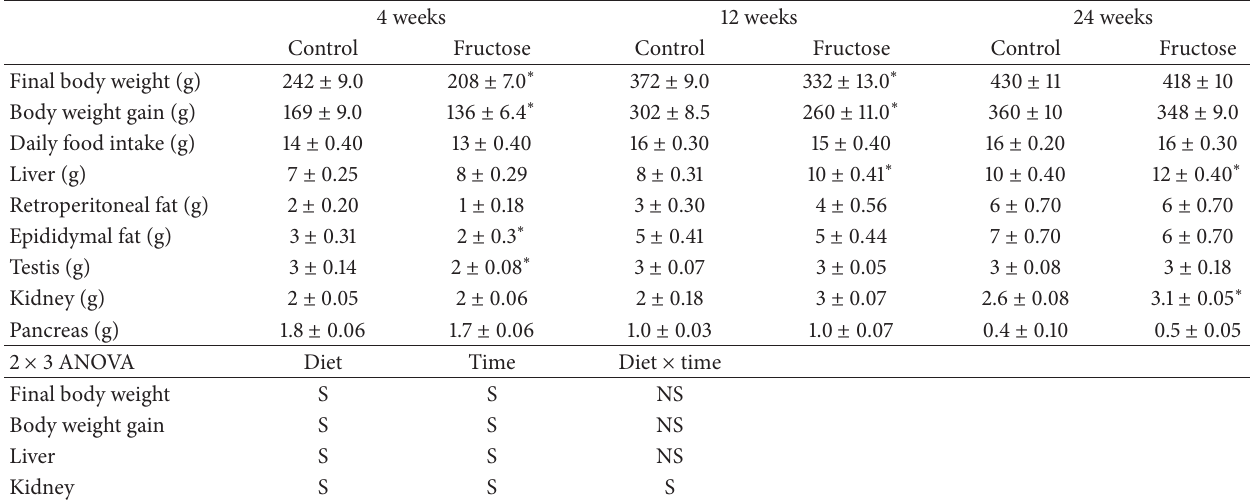
Table 2: Physical